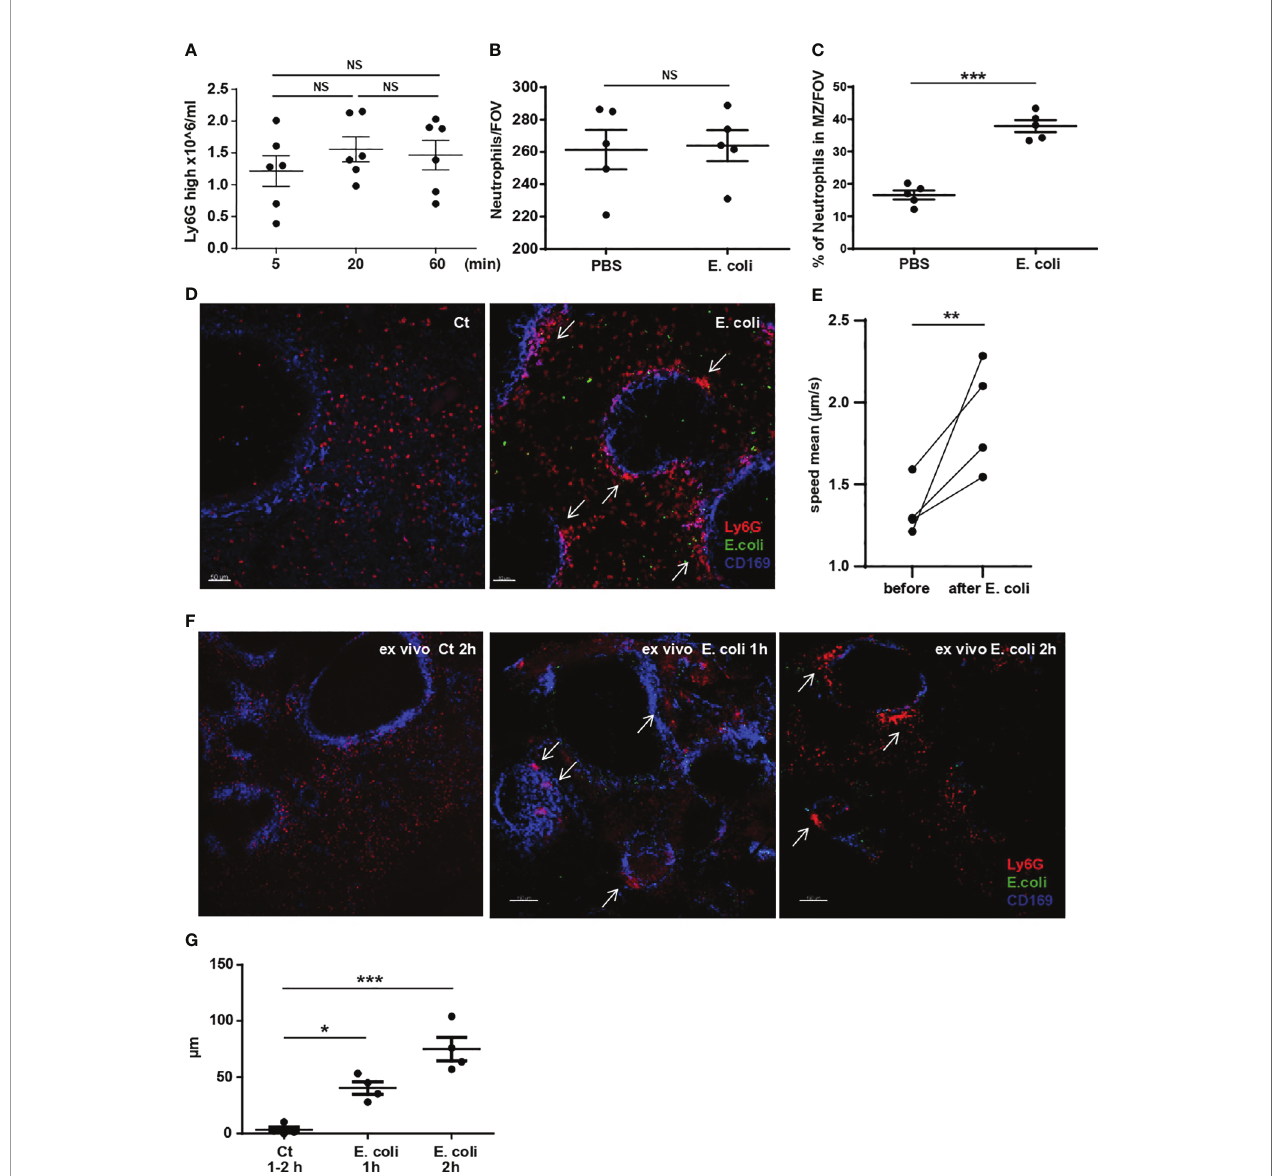
FIGURE 3 | Splenic resident neutrophil activation and redistributing within the spleen after systemic E. coli challenge. (A) Total number of splenic neutrophils 5, 20 and 60 min after i.v. injection of E. coli , evaluated by fl ow cytometry, one-way ANOVA, Tukey ’ s multiple comparison test, three independent experiments, (N=6 mice/ timepoint). (B) Total number of neutrophils/FOV counted in PCSS after PBS or challenge with E. coli for 60 min, unpaired t-test (N=4 mice/group), (10 FOV/mouse). (C) % of splenic neutrophils located in the MZ/FOV counted in PCSS after PBS or E. coli challenge for 60 min, unpaired t-test , (N=4 mice/group), (10 FOV/mouse). (D) PCSS image after PBS or challenged with E. coli for 60 min. Scale bar 50 m m. Arrows point to neutrophil clusters in the MZ. (E) S-IVM analyzed for neutrophil mean speed comparing before and 60 min after E. coli challenge, paired t-test , (N=4 mice). (F) 3D ex-vivo culture system of living PCSS for 1h and 2h, pre- challenged with systemic E. coli for 5min or PBS (Ct). Scale bar 150 m m. P < 0.05 *, P < 0.01 **, P < 0.001 ***, NS=not signi fi cant. Arrows point to neutrophil clusters in the MZ. (G) Diameter of neutrophil clusters in 3D ex vivo culture system of living PCSS cultured for 1h or 2h, pre-challenged with systemic E. coli for 5 min or PBS, one-way ANOVA, Tukey ’ s multiple comparison test, four independent experiments, (N=4